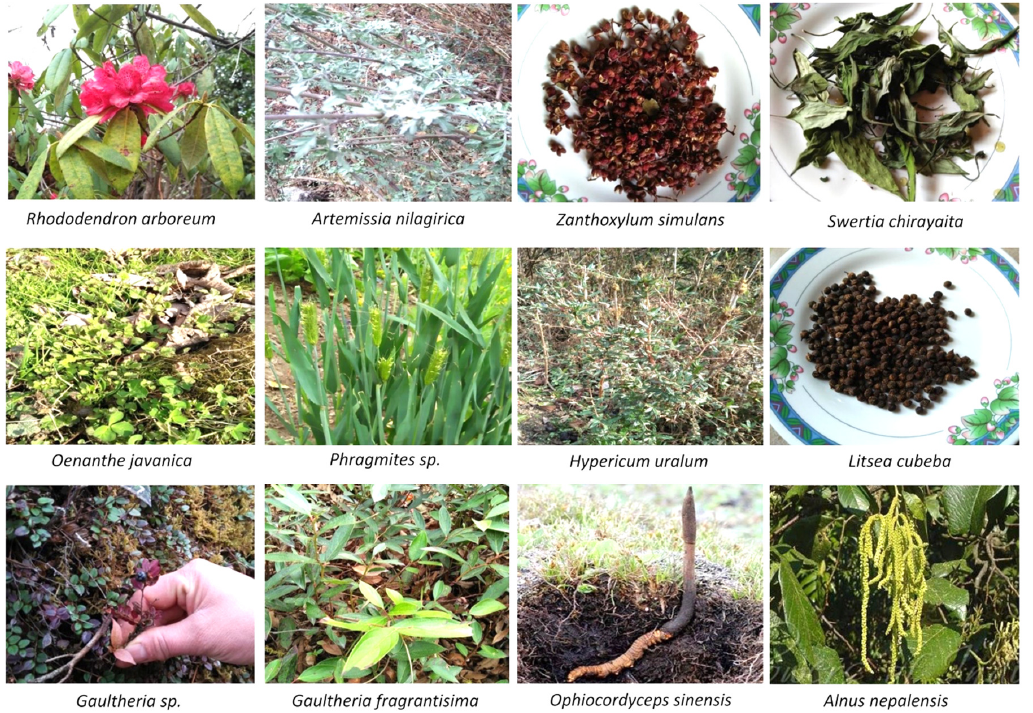
Figure 6. Some of the medicinal plants used by the Monpas of Dirang, Arunachal Pradesh in curing various